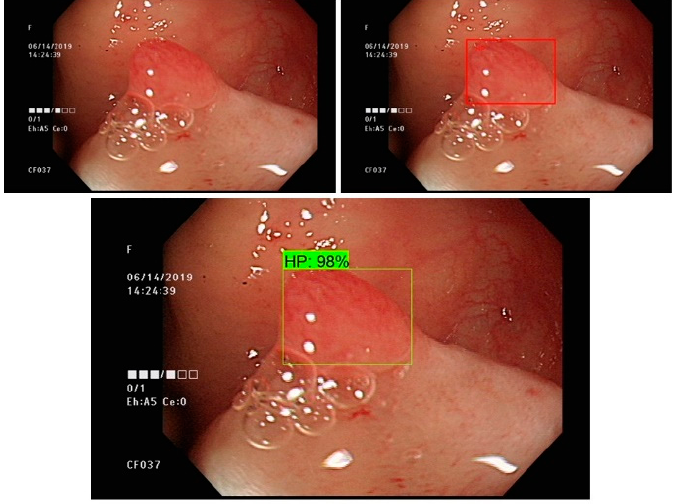
Figure 1. Results of polyp detection and classification system (( upper left ): original colonoscopy, ( upper right ): annotated polyp, ( below ): CAD bounding box with classification).